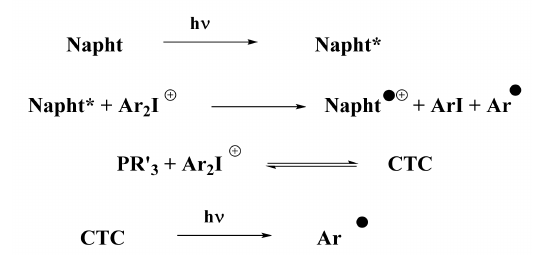
(abbreviations: Napht for the new naphthalimide derivatives, Ar 2 I + for the iodonium salt, PR’ 3 for the phosphine, and CTC for the charge-transfer